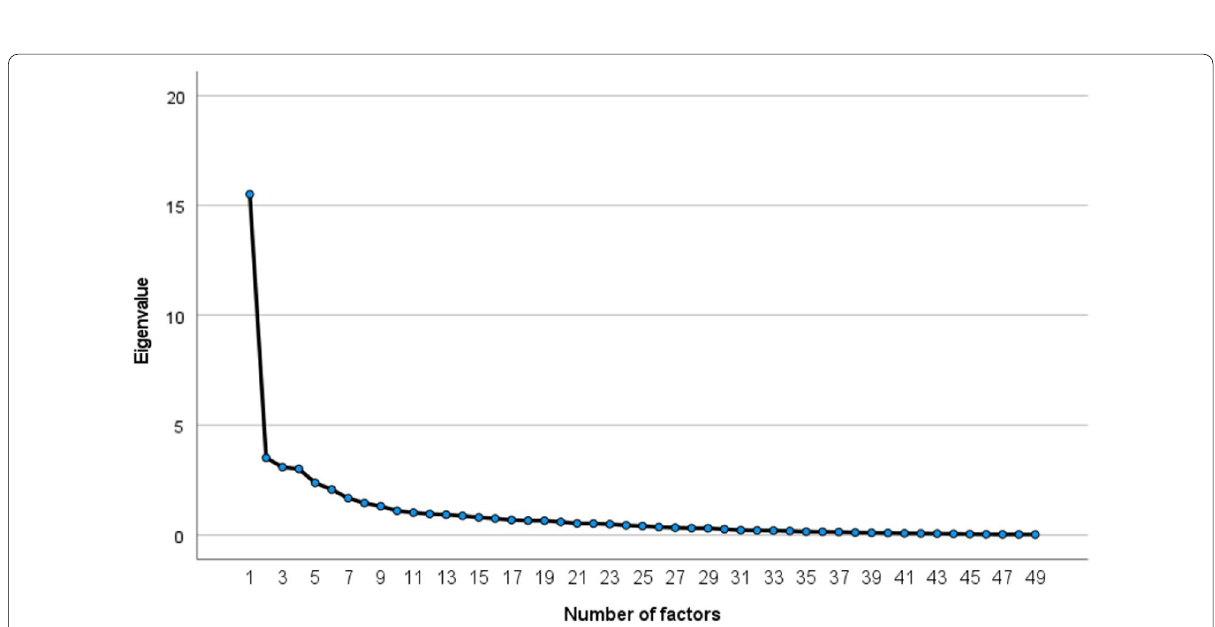
Fig. 2 Scree plot generated from exploratory factor